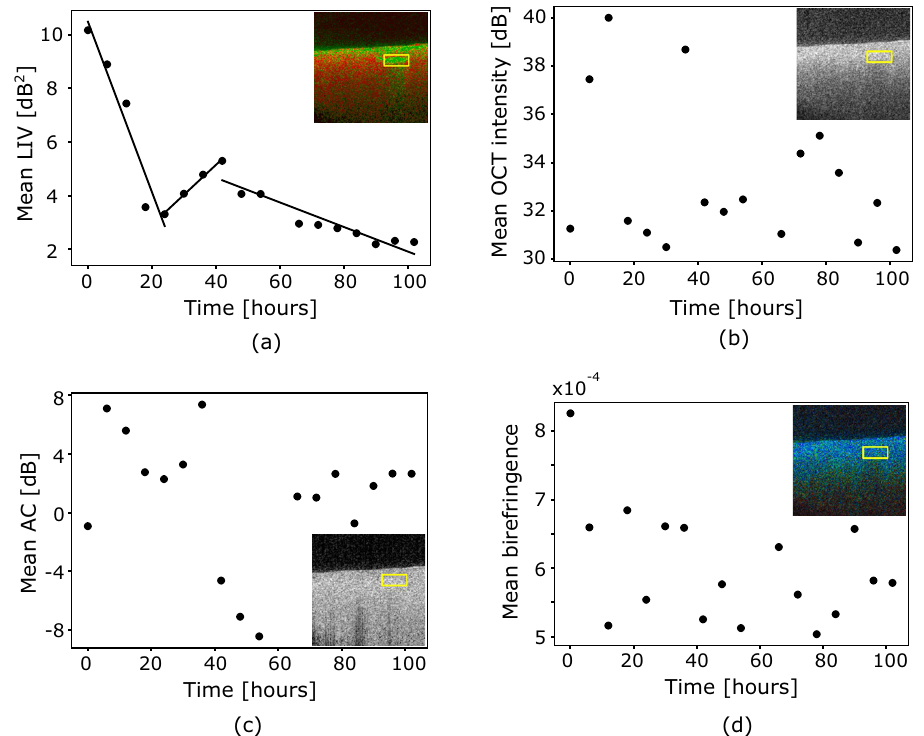
Figure 5. Time-course plots of mean ( a ) LIV, ( b ) OCT intensity, ( c ) attenuation coefficient (AC), and ( d ) birefringence of healthy mouse liver. The mean values of each quantity are computed within the region indicated by the yellow rectangular box shown in the insets of ( a – d